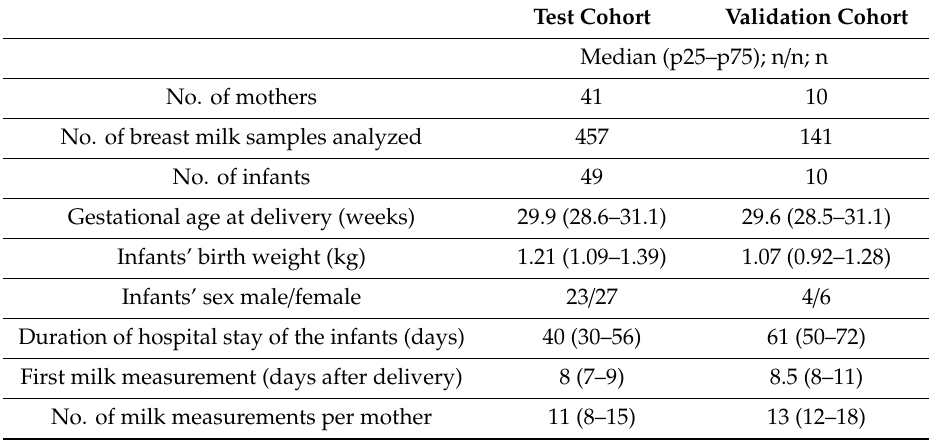
Table 2. Demographic data of patients in the underlying study shown as median (p25–p75) or number in the test and validation